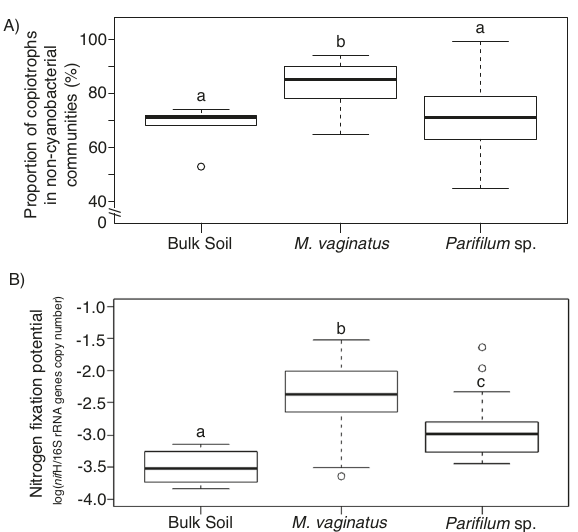
Fig. 5 Trait-based analysis of cyanosphere communities. A Propor- tion of copiotrophic taxa in bulk soil, M. vaginatus and Pari fi lum sp. cyanospheres ( n = 5, 24 and 21, respectively). Communities asso- ciated with M. vaginatus contained higher proportions of copio- trophs than either bulk soil or Pari fi lum sp. communities ( P < 0.006 for both), while bulk soil and Pari fi lum sp. communities had similar proportions ( P = 0.449), according to non-parametric Kruskal-Wallis tests, with Dunn post-hoc tests. B N 2 - fi xation potential of the same non-cyanobacterial microbial communities as in ( A ), determined by their ratio of nif H to 16 S rRNA genes copy number. While M. vaginatus and Pari fi lum sp. communities had higher nitrogen fi xation potentials than bulk soil ( P < 0.001 and 0.06, respectively, according to ANOVA with Tukey post hoc tests, on log-transformed data to ensure normality), M. vaginatus communities had a signi fi cantly higher potential than Pari fi lum sp. ( P <